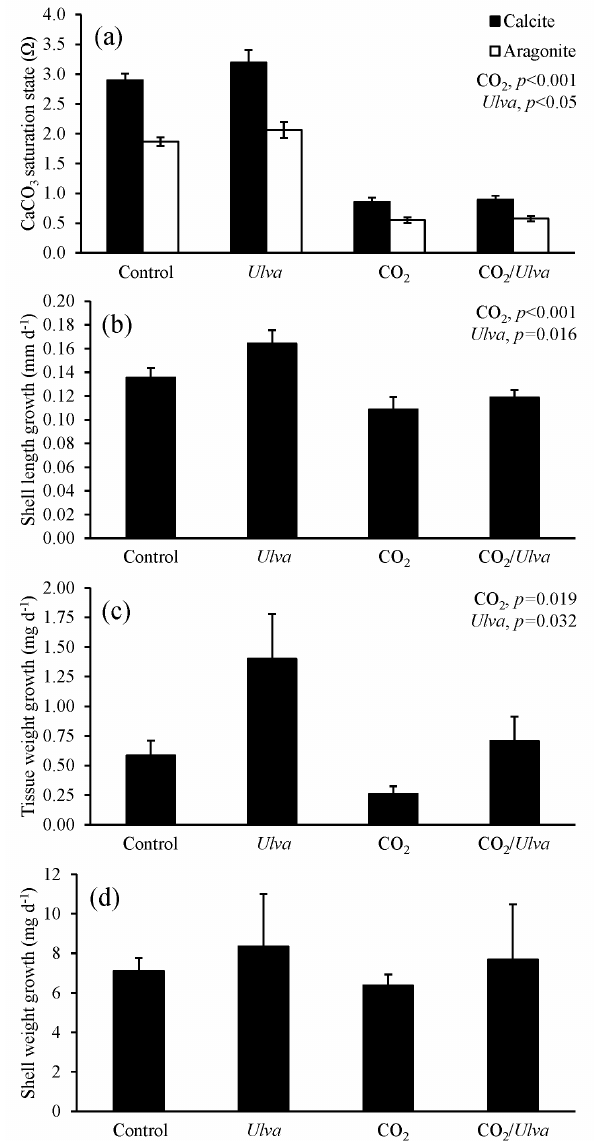
Figure 7. Experiment with Mytilus edulis exposed to ambient and elevated concentrations of CO 2 with and without the presence of Ulva . (a) (cid:127) calcite and (cid:127) aragonite ; growth was based on (b) shell length, (c) tissue weight, and (d) shell weight. Columns represent means ± standard deviation. Significant main treatment effects (CO 2 and Ulva ) appear at the top right of each